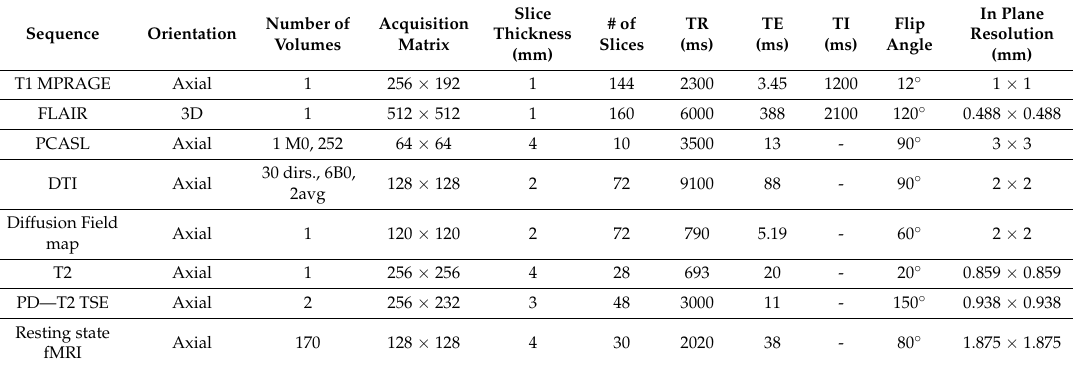
Table 1. MRI Sequences Deployed in the PUFA